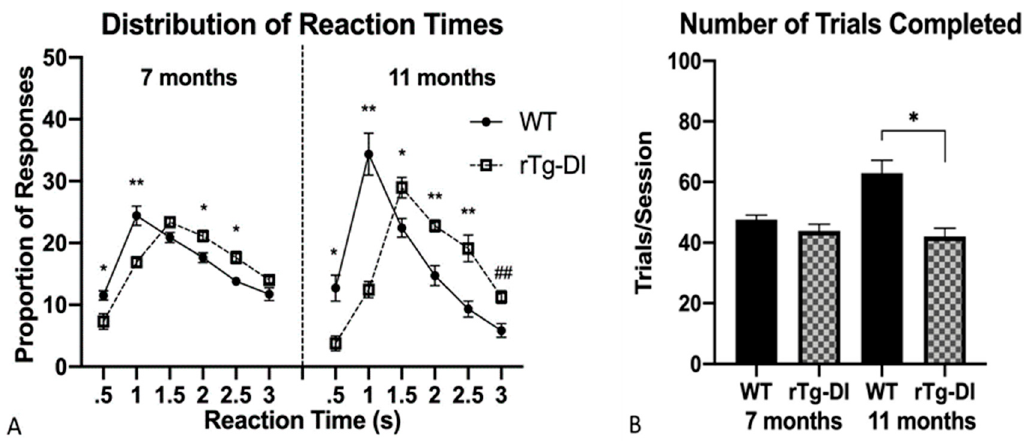
Figure 4. Responses on a reaction time task (REACT). ( A ) rTg-DI rats showed a shifted reaction time distribution at 7 months of age, becoming more pronounced at 11 months. ( B ) rTg-DI rats completed fewer trials than WT only at 11 months of age. Data represent mean +/ − SEM. ## p < 0.005, * p < 0.01, ** p < 0.001.